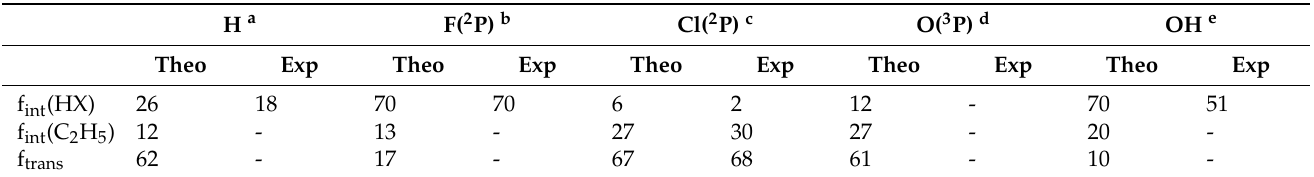
Table 3. Theoretical/experimental average fraction of the available energy in products, XH + C 2 H 5 , for the X + C 2 H 6 reactions. Values in percentage.